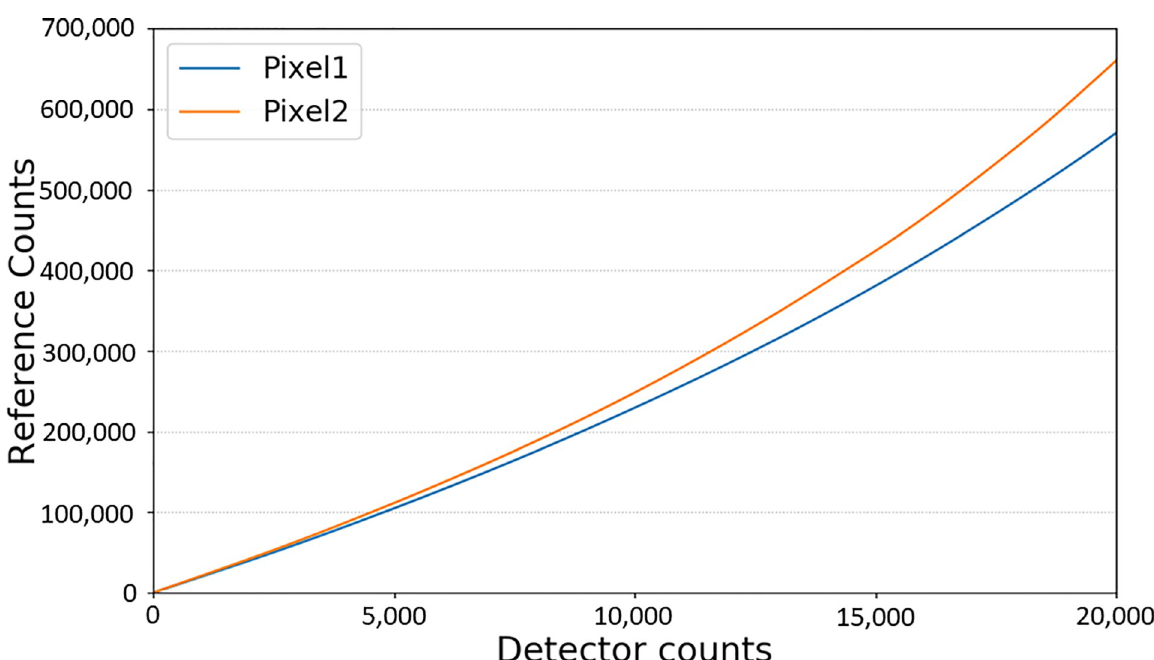
Fig 14. Detector–response curves of two different detector pixels. This non-linear behavior requires a sophisticated non-linearity correction, unlike the conventional energy-integrating